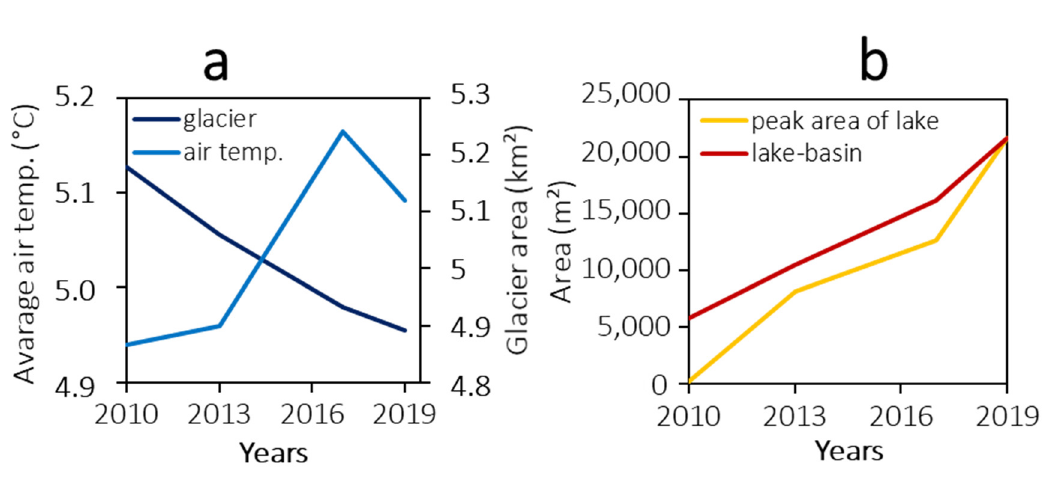
Figure 6. Average air temperatures (June–July) and areas of the Toguz-Bulak glacier, lake and lake basin. ( a ) Air temperature and glacier area. ( b ) Lake and lake basin areas. Air temperature data from MS Tien Shan.